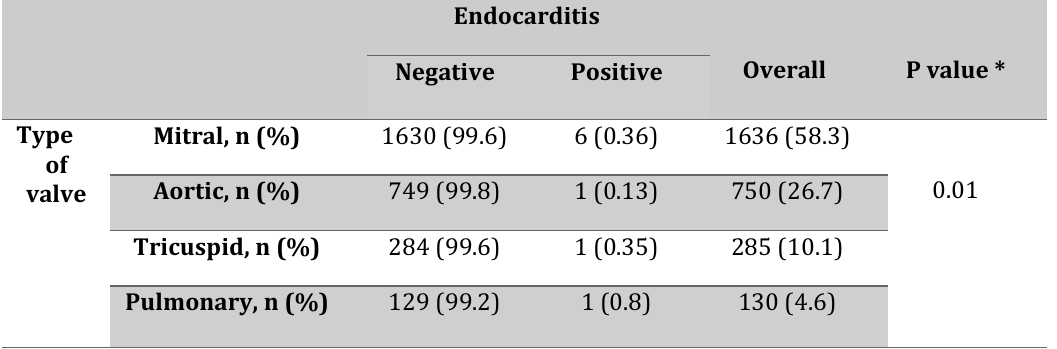
Table 3. Comparison type of valve surgery in patients with and without